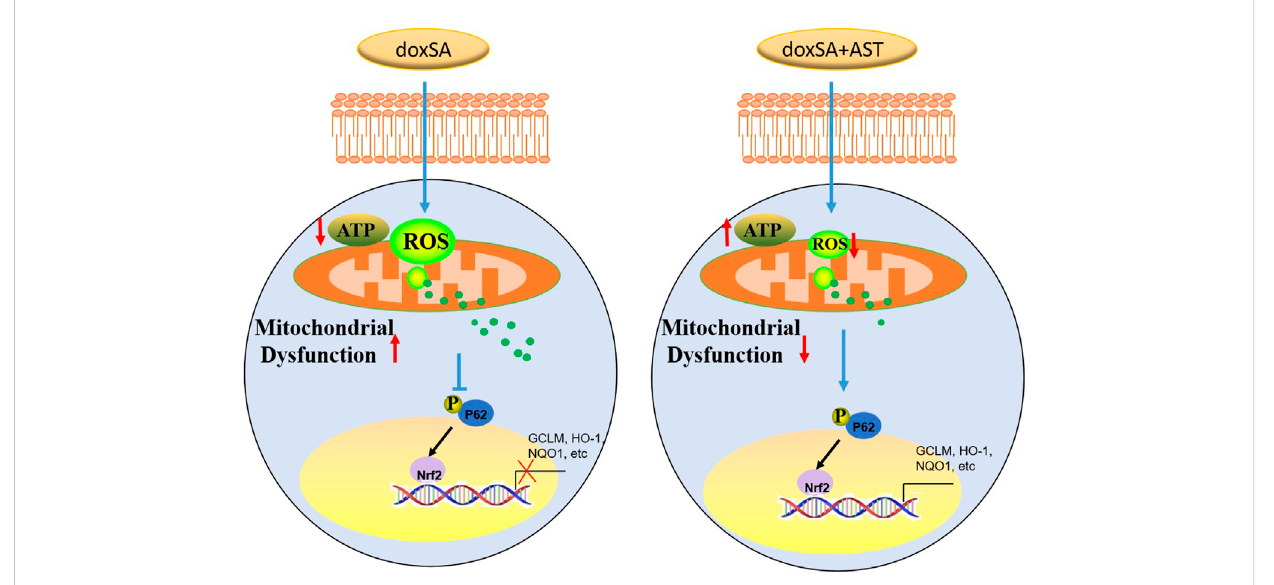
FIGURE 7 Schemic representation of the signaling involved in this